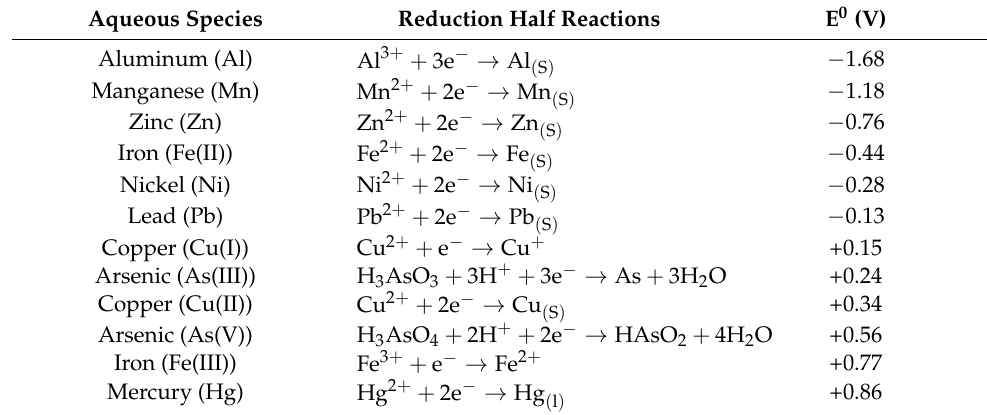
Figure 5. A comparison of the removal of various PTE from the synthetic combined AMD by Fe-Al bimetallic particles after 90 min and initial pH 2. Table 2. Standard reduction potential of different species in aqueous solution at 25 °C [24,42].